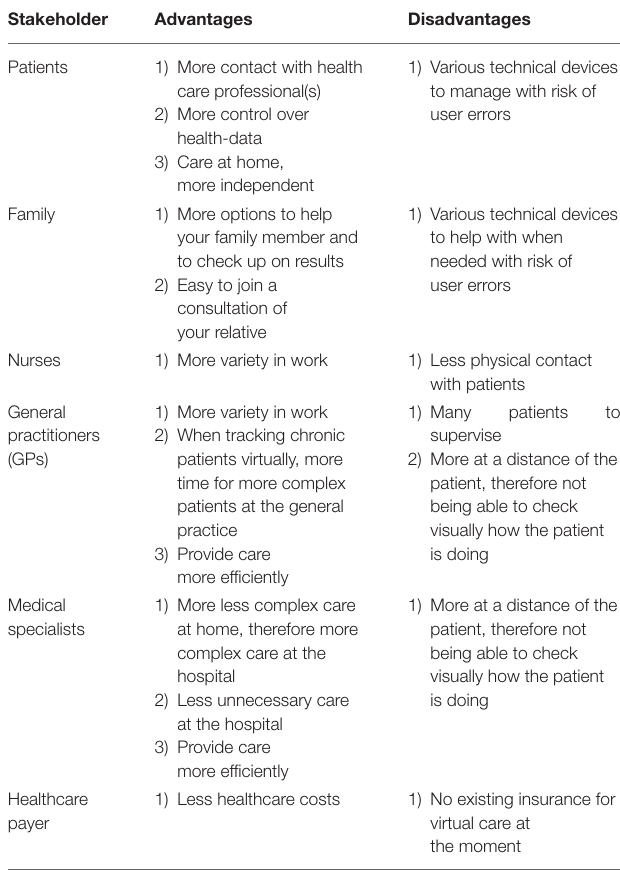
TABLE 2 | Overview of advantages and disadvantages for all stakeholders when switching to the virtual care center.